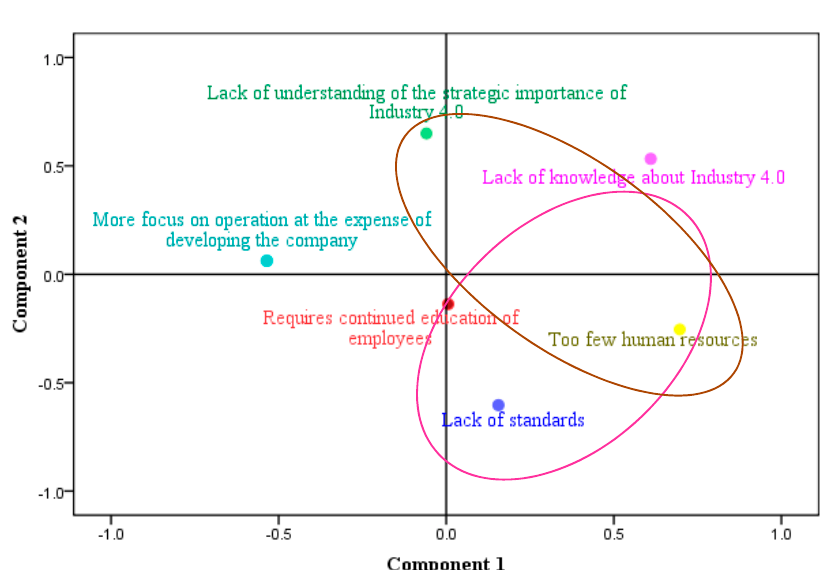
Figure 5. Graphical representation of the association between six variables and the main components.